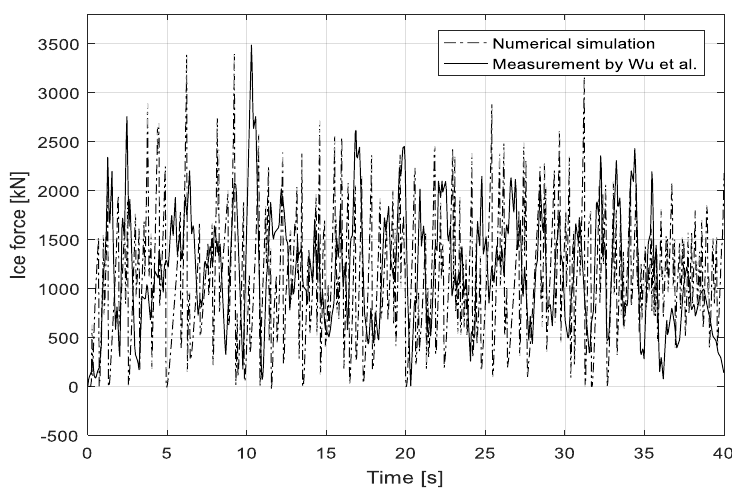
Figure 16. Time history of ice force from the measurement and simulation for test 304.